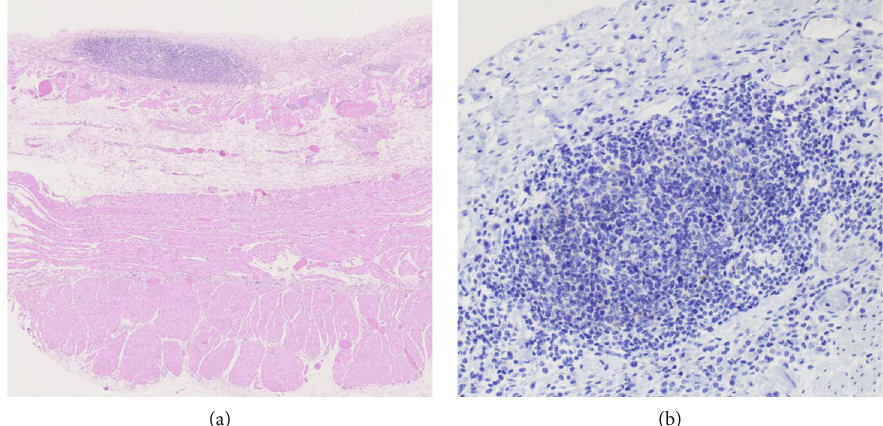
Figure 4: Histologic section of the pericardium, showing pericarditis without a large cell in fi ltrate (a) and absence of staining for HHV8 (b). Table 1: A comparison of the typical immunophenotype and viral association in HHV8-positive DLBCL, PEL, and PBL.